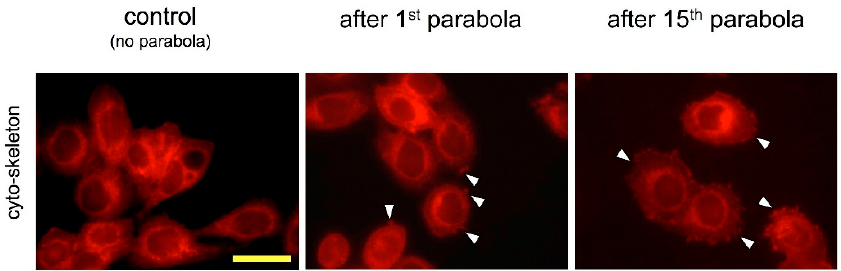
Figure 14. Cytoskeleton visualization in MDA-MB-468 cells of the first Swiss Parabolic Flight Campaign by using phalloidin staining. After the first parabola numerous cells showed single to few protrusions or lamellipodia. After the 15th parabola, almost all cells showed protrusions or lamellipodia allover the entire circumference of the cell border (arrow heads). Scale bar = 20 µm.